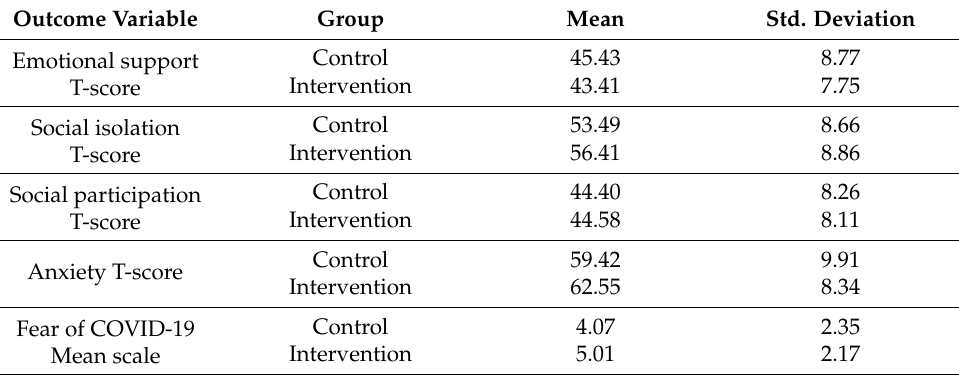
Table 2. Comparison of the two research groups, control ( n = 68) and intervention ( n = 67), in terms of outcome measures at